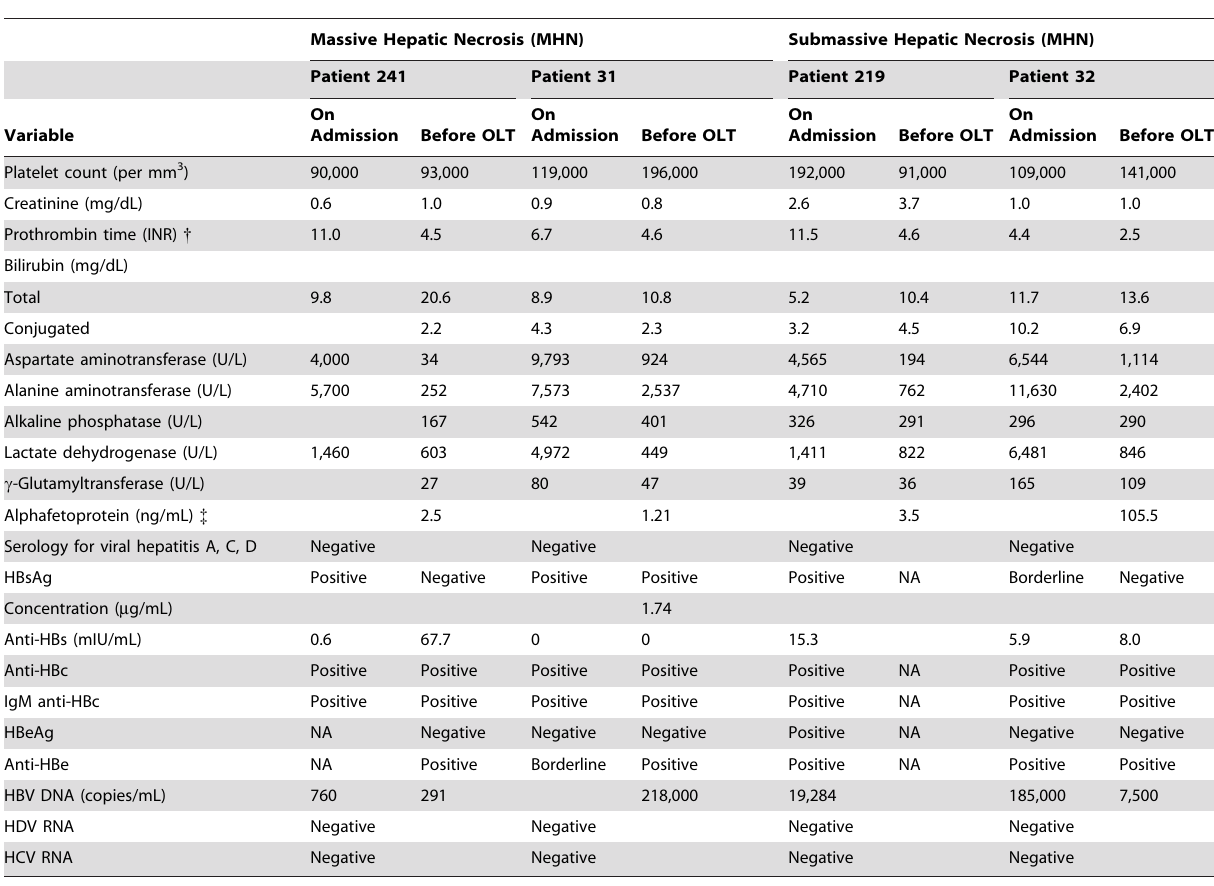
Table 1. Results of laboratory tests in four patients with HBV-associated acute liver failure.